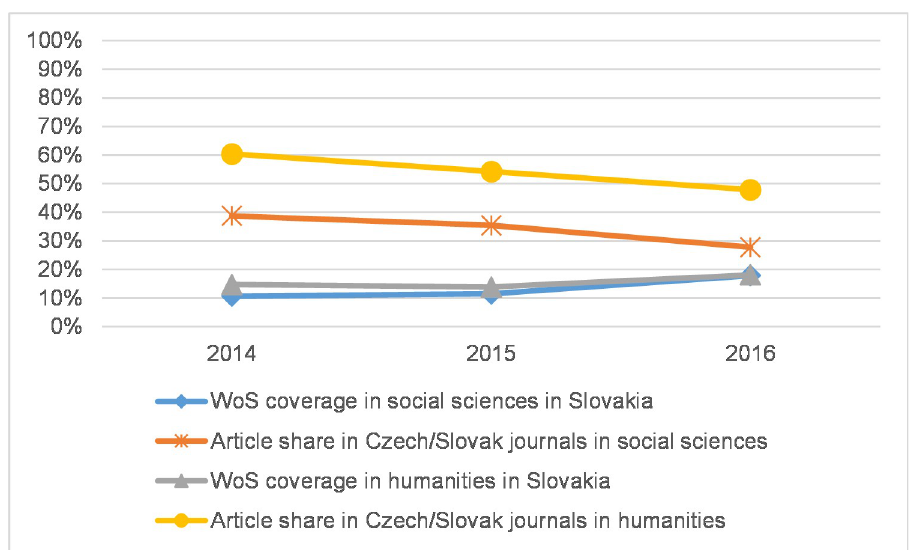
Fig 10. WoS coverage and regional journal article share in Slovakia.